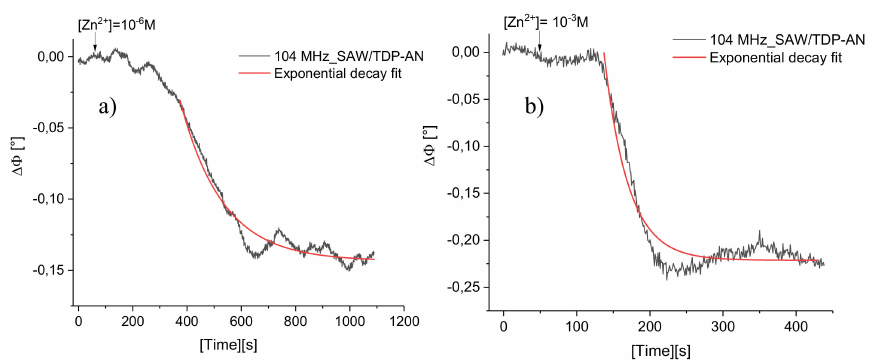
Figure 11. Phase-shift ( ∆Φ ) variations versus time for 104 MHz_SAW / TDP-AN sensor after the injection of a zinc ion solution at a concentration of ( a ) 10 − 6 M; ( b ) 10 − 3